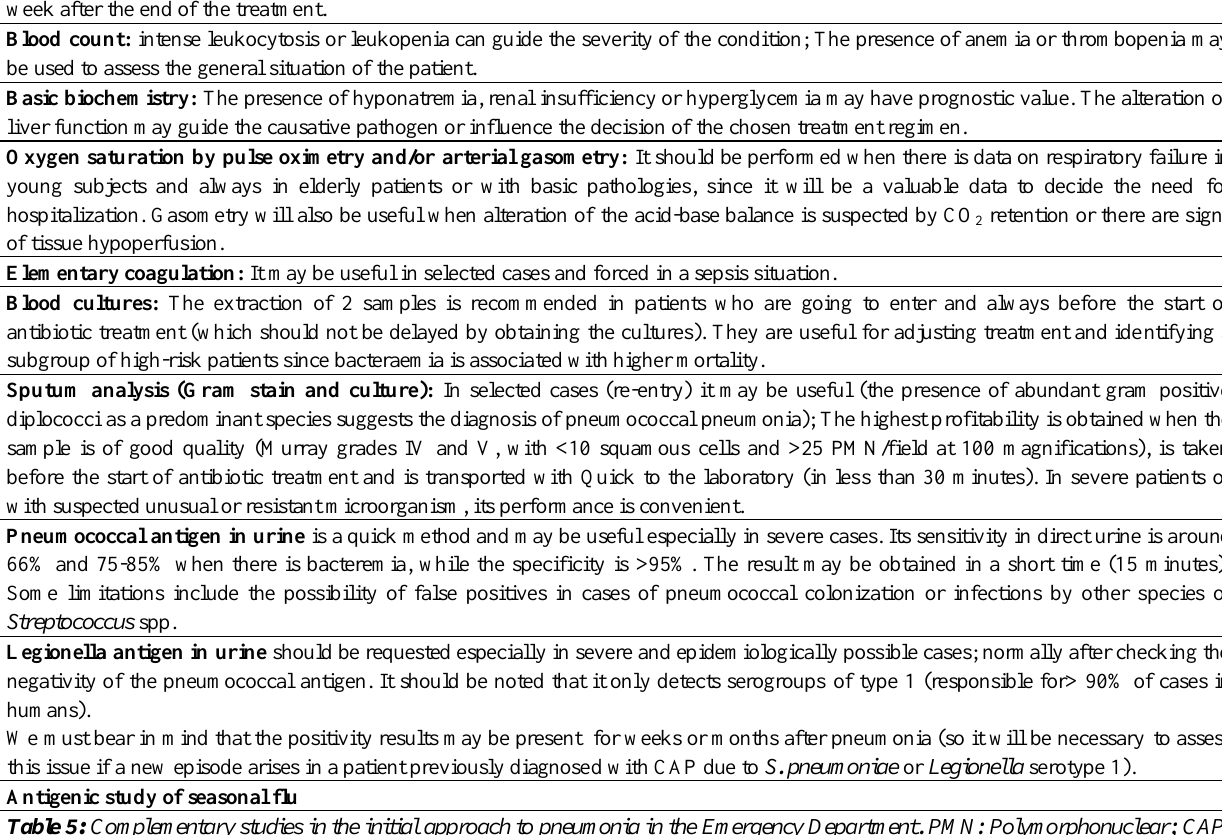
Table 5: Complementary studies in the initial approach to pneumonia in the Emergency Department. PMN: Polymorphonuclear; CAP: Community acquired